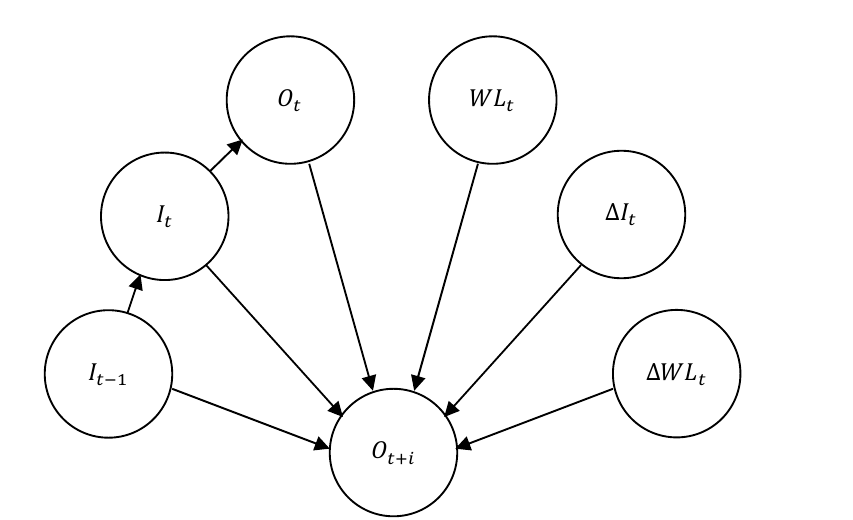
Figure 3. BNet structure that forecast the discharge flow of the reservoir at time 𝑡 + 𝑖 hours, where 𝑖 = 1 to 5 h.